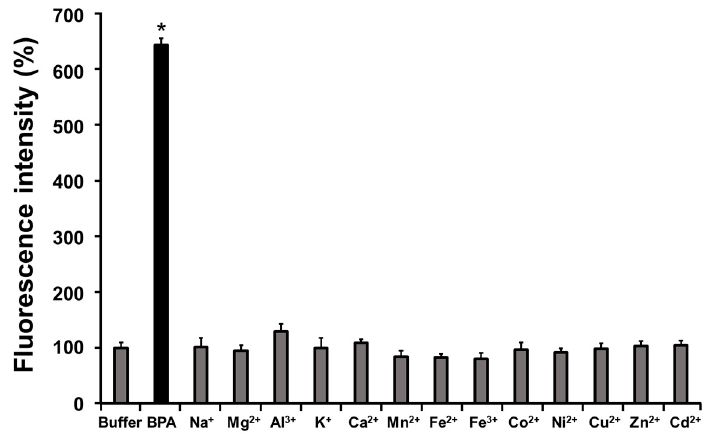
Figure 3. BS-631 fluorescence intensity (100 µM) 60 min after addition of BPA or metal cation (1.0 mM, pH = 7.4) * p < 0.05 vs. buffer (PBS(-) only) by Dunnett’s multiple comparison test.